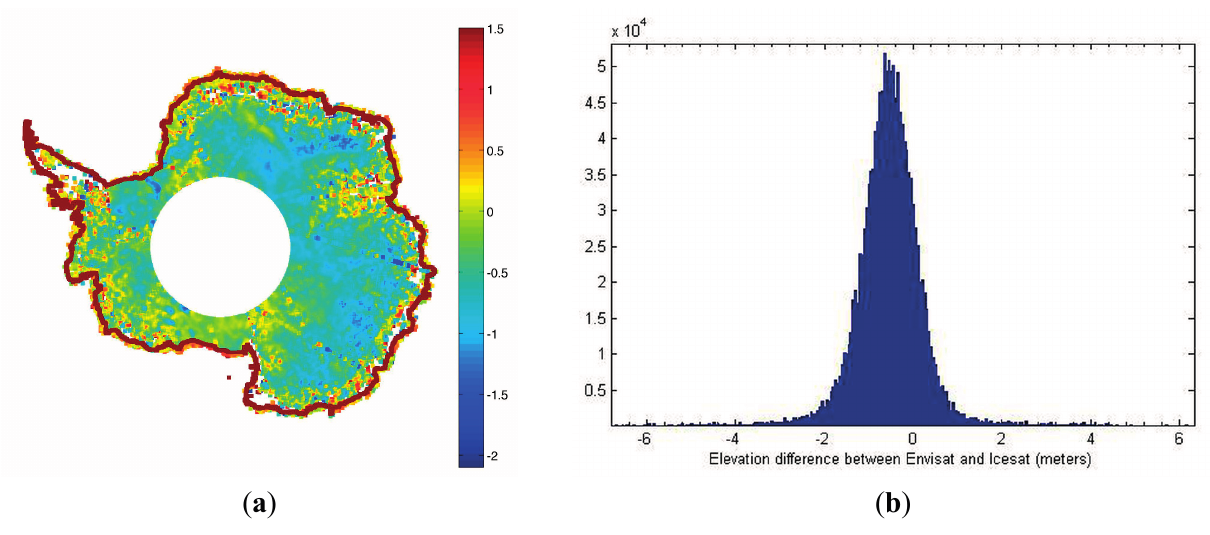
Figure 3. ( a ) Mean elevation difference between ICESat and ENVISAT in meters. Added to the poorer sampling on the coasts, we see the elevation difference is positive over the coasts due to the slope induced-error. Anywhere else, the elevation difference is mainly about − 0.5 m, from − 0.5 to − 1 m depending on the places. The dark circles demarcate the areas we focus on: mainly The Dronning Maud Land, as well as the MacRobertson Land (upper circle) and the Plateau (down circle); ( b ) histogram of the elevation difference between ICESat and ENVISAT for slopes inferior to 9 m/km. The X-axis is in meters, the Y-axis is in